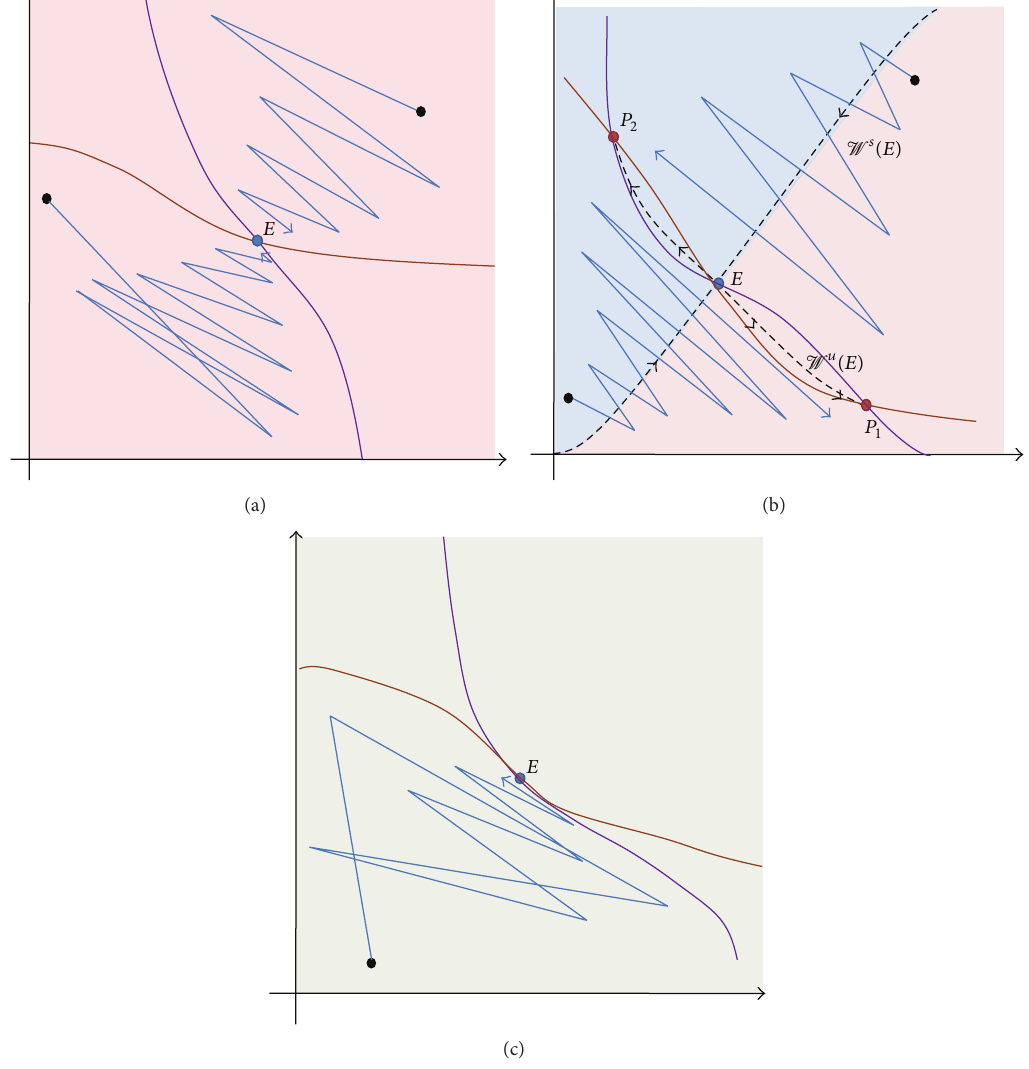
Figure 1: Visual illustration of Theorem